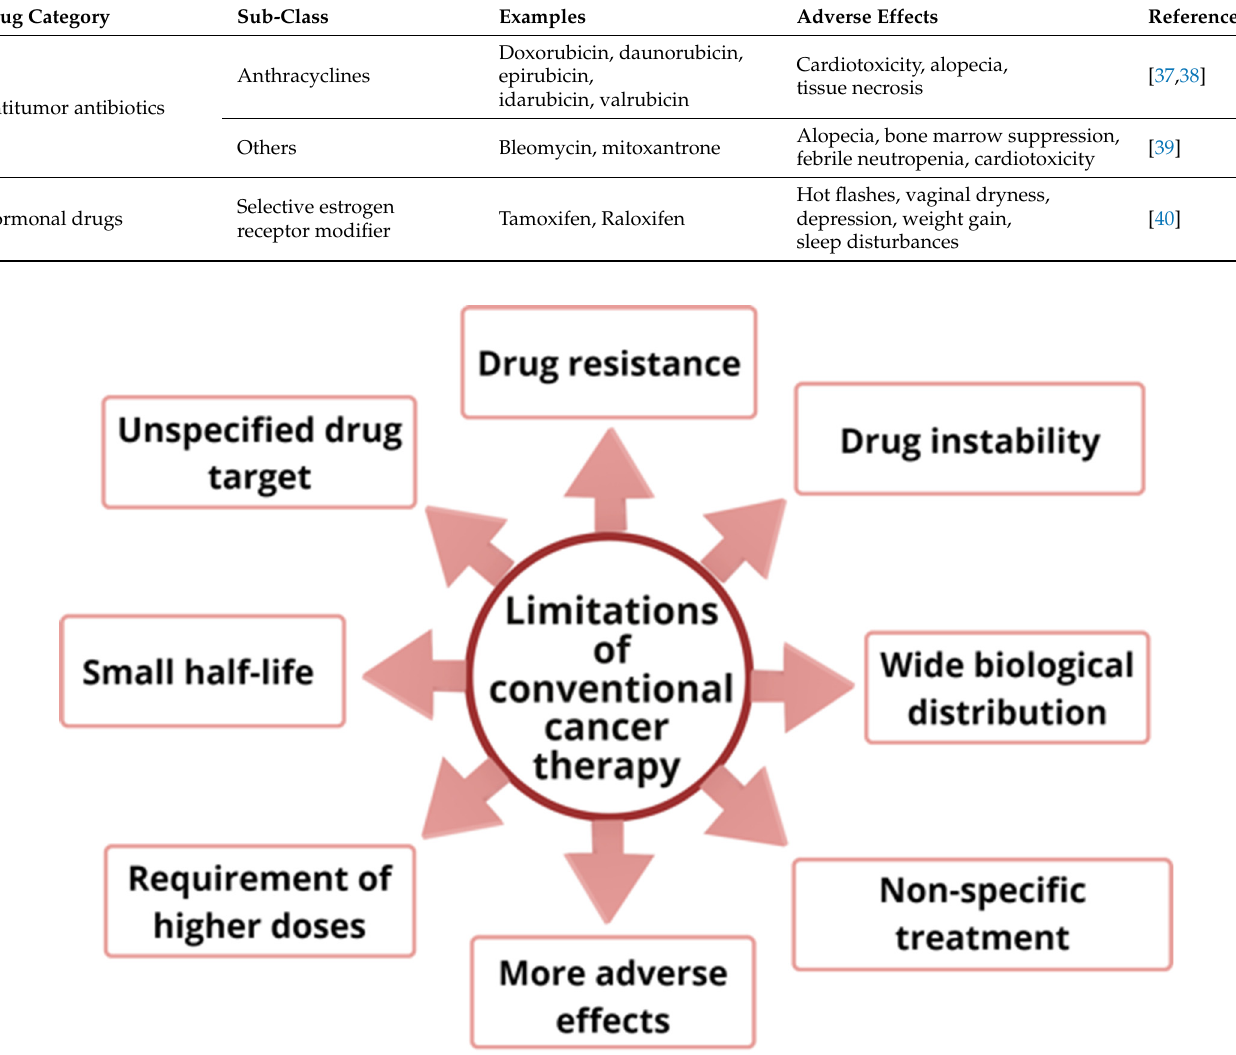
Figure 2. Various hindrances associated with conventional anticancer